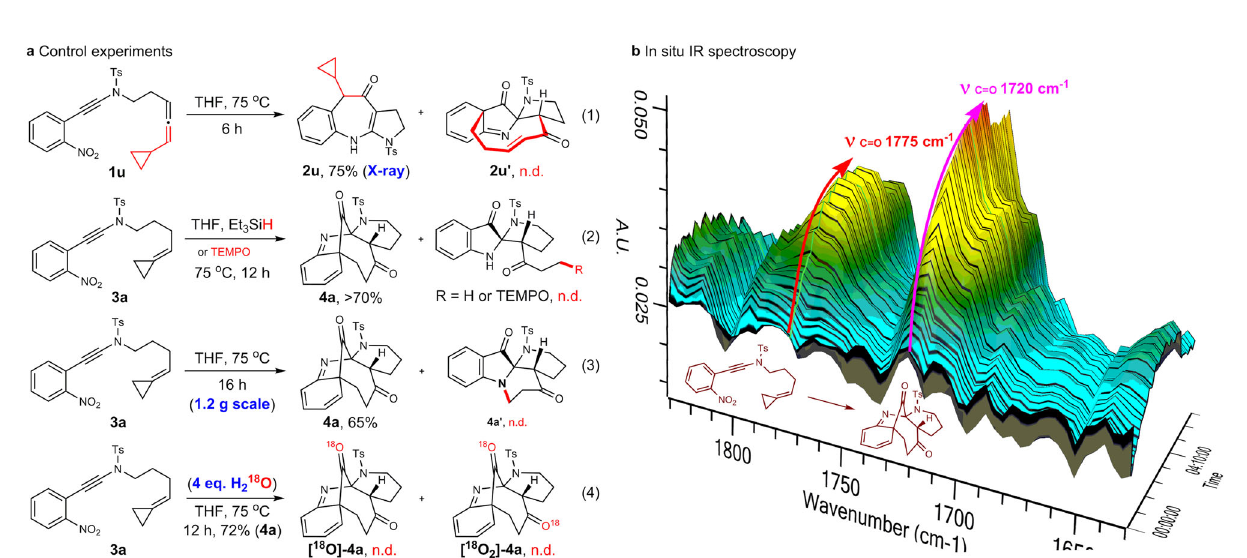
Fig. 7 | Mechanistic investigation and gram-scale synthesis. a Control experi- ments: The Eqs. 1 and 2 indicate that no radical is involved in the (homo-)hetero- Claisen rearrangement. Eq. 3 is robust and radical mediated Brandi cyclization